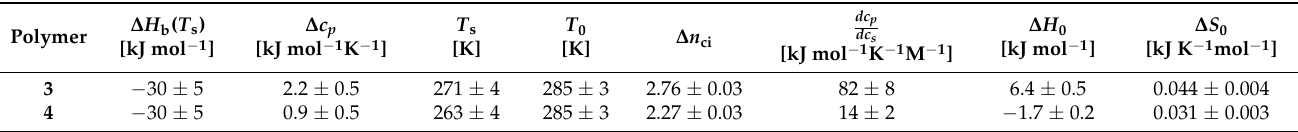
Table 1. Thermodynamic parameters obtained from fits of Equations (7) and (14) with an estimate of their error margins.